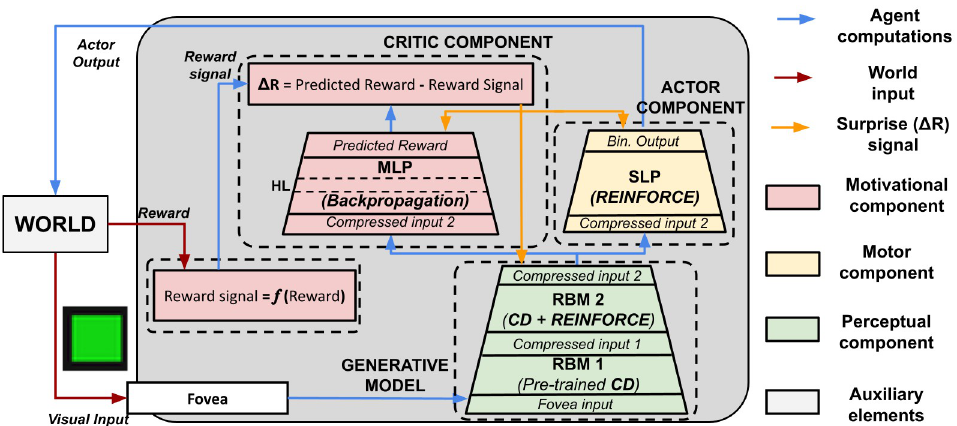
Fig 4. A computational schema of the model components and their training algorithms, the flows of information between the components, and the learning signals. MLP: Multi-layer Perceptron. SLP: Single-layer Perceptron. HL: Hidden Layer. RBM: Restricted Boltzmann Machine. CD: Contrastive